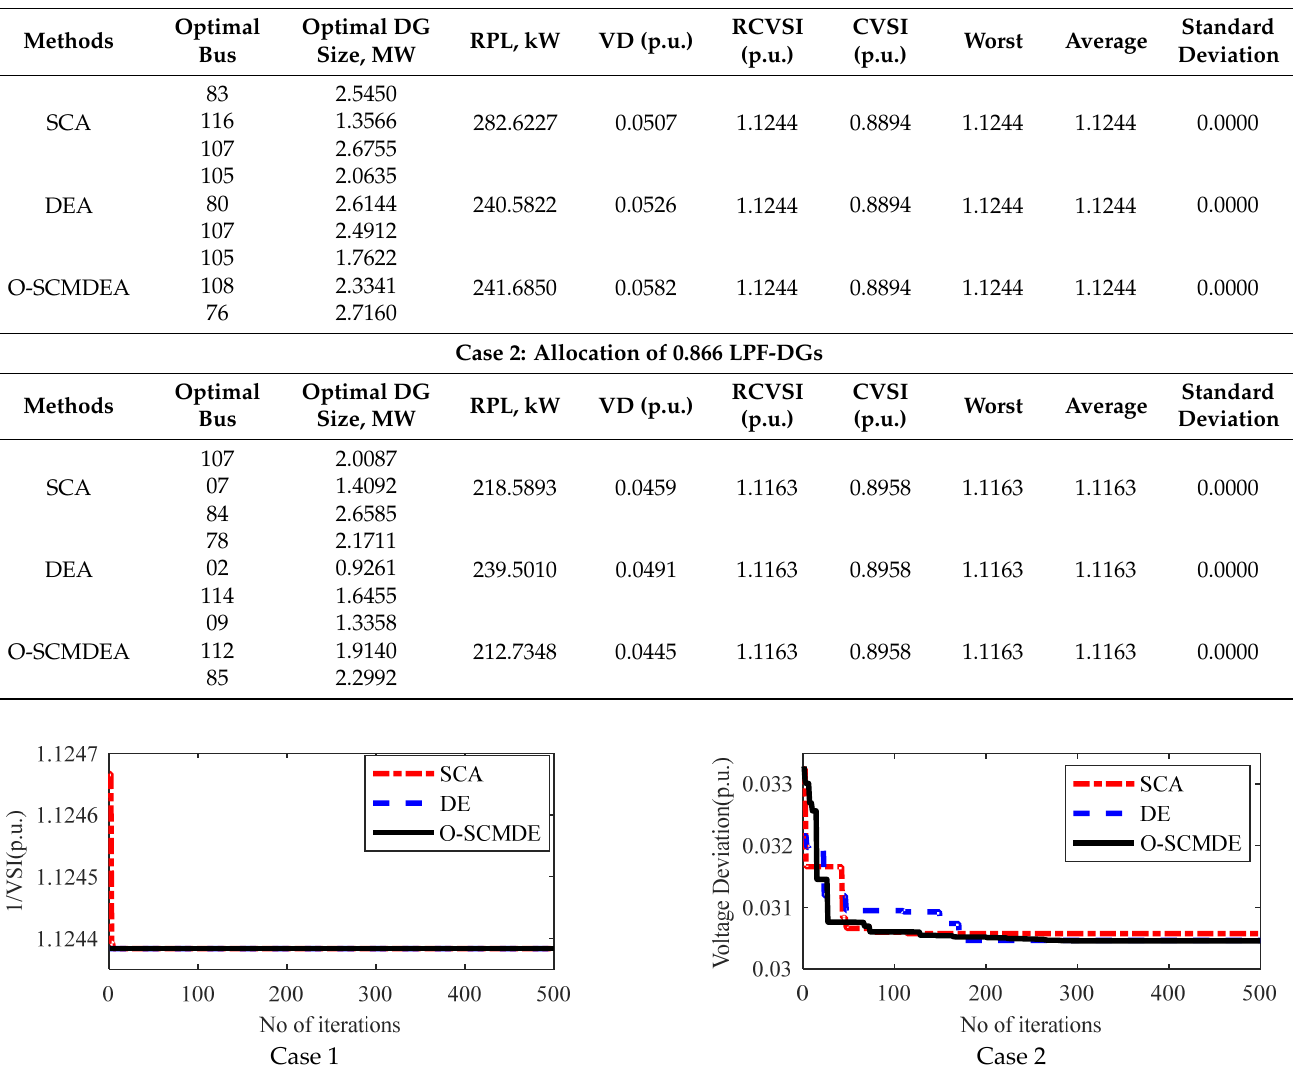
Figure 16. Comparison of the convergence characteristics of the SCA, DEA and O-SCMDEA for both cases of scenario III of the 136 bus system.